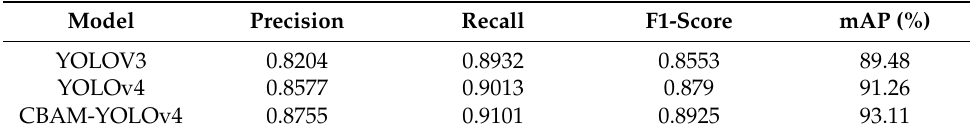
Table 4. The results of wheat ear detection based on different methods.